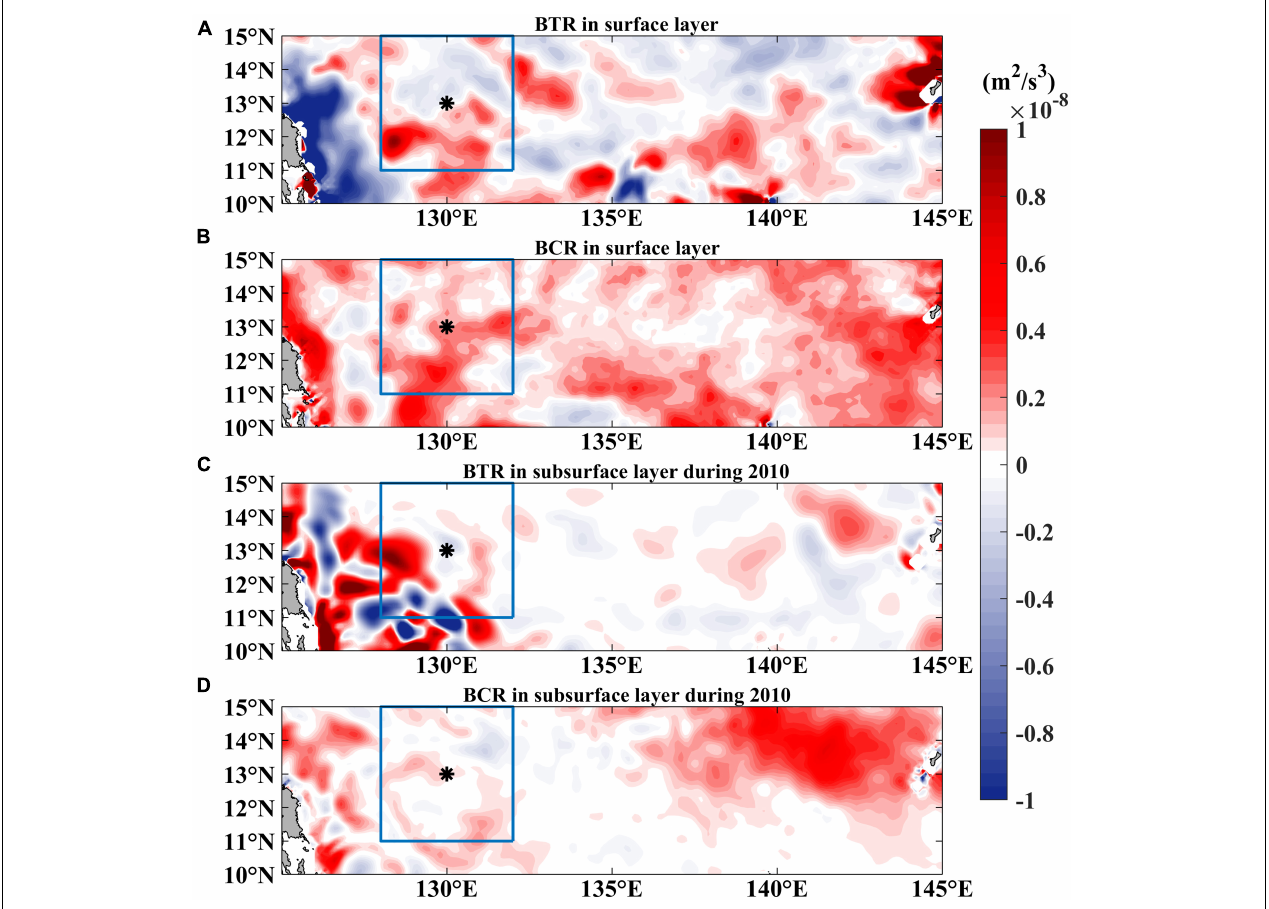
FIGURE 12 | Climatological mean barotropic (A) and baroclinic (B) energy conversion rate in the surface layer (0–150 m) derived from OFES outputs during 2010–2016. (C,D) are the same as (A,B) but for the subsurface layer (400–600 m) during 2010.